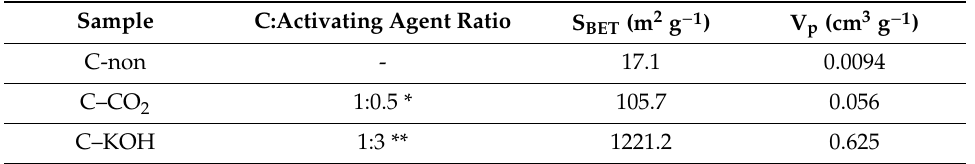
Table 2. The Brunauer-Emmett-Teller (BET) surface area (S BET ) and total pore volume (V p ) of the activated carbon obtained from the chestnut.